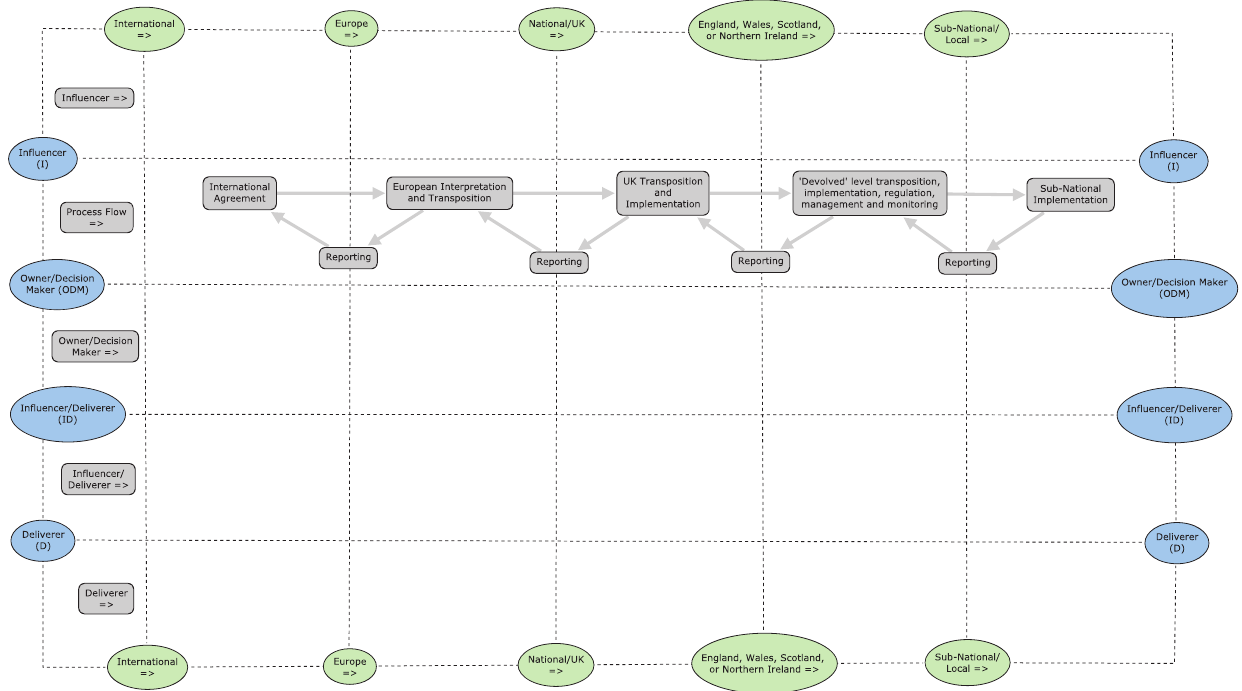
Figure 1. Example of the policy actor template. In the actor template the policy process flow is from left to right and this is mirrored by the policy domains of actors from international on the left through to local actors on the right. The rows aggregate actors on the basis of the categories described in table 1.